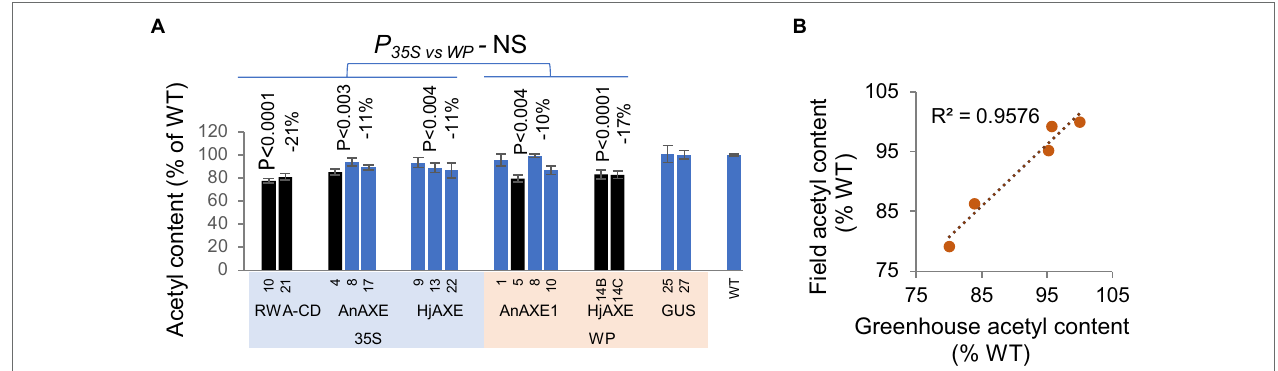
FIGURE 3 | Acetyl content of lignocellulose biomass from stems of transgenic five-year-old field-grown aspen. (A) Acetyl content, in percentages of wild-type (WT) levels. Means ± SE . Significant downregulation, according to ANOVA followed by Dunnett’s test ( p < 5%), is indicated by black color. The values of p show the significance of differences between all the lines carrying indicated constructs and WT plants (post-ANOVA contrast, shown when < 5%). There was no significant differences (NS) in effects of the promoters in acetyl content according to ANOVA F -tests. (B) Correlation of acetyl contents between field-grown (“Field”) and greenhouse-grown (“Greenhouse”) WP:AnAXE1